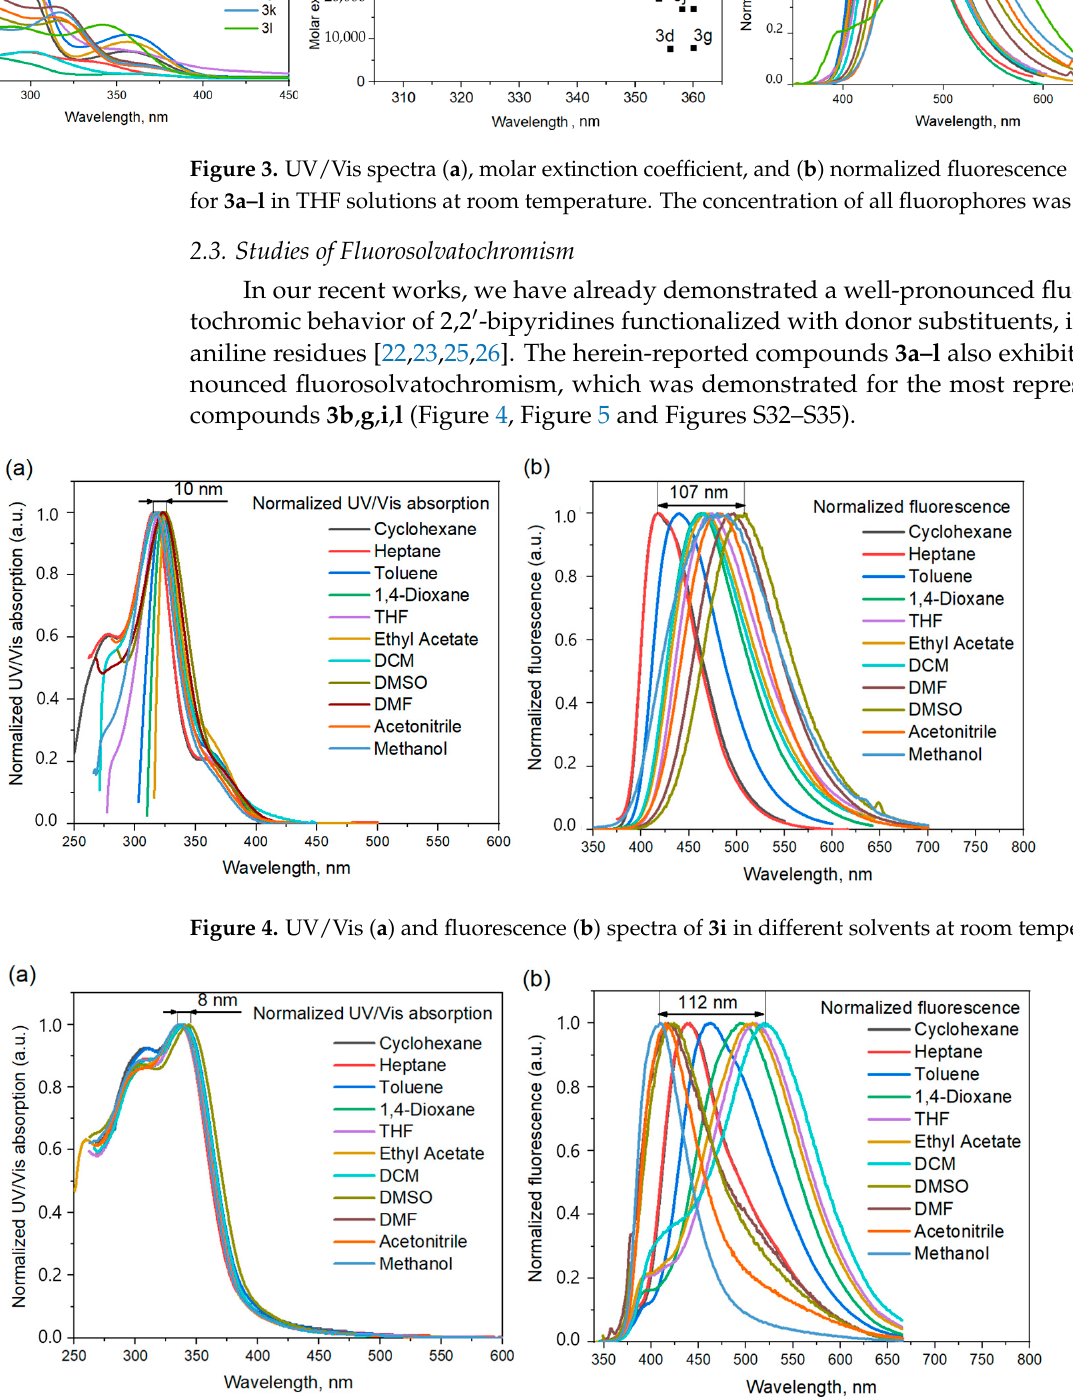
Figure 5. UV/Vis ( a ) and fluorescence ( b ) spectra of 3l in different solvents at room temperature .